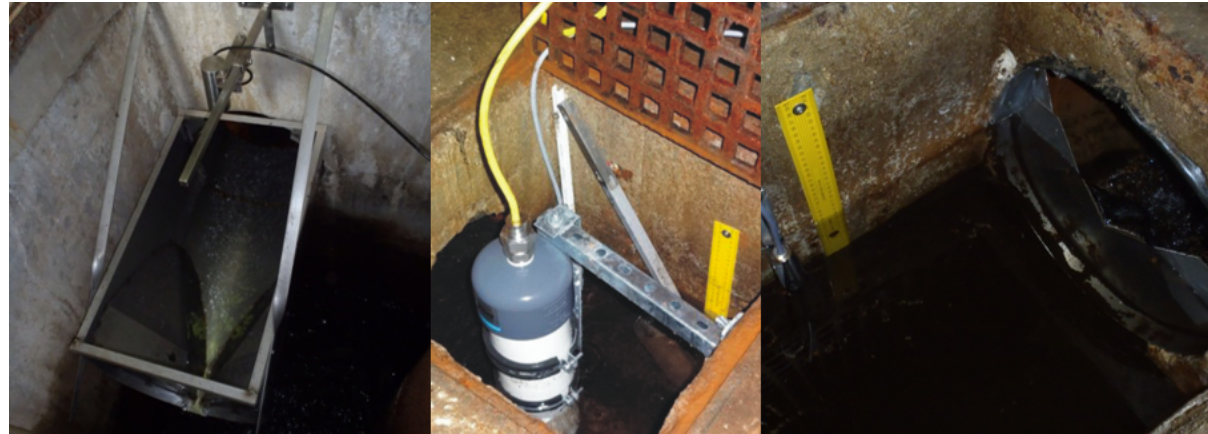
Fig. 2. Water level measurement in the channel. On the left: ultrasonic probe (in the observation point V8). In the middle: a cylinder with the load string (H104). On the right: the pressure probe (H248).